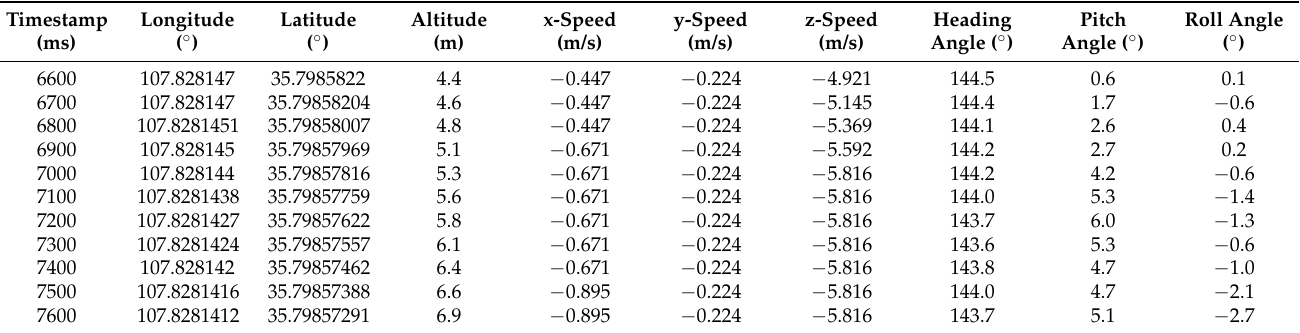
Table 2. Trajectory data illustration for drones.